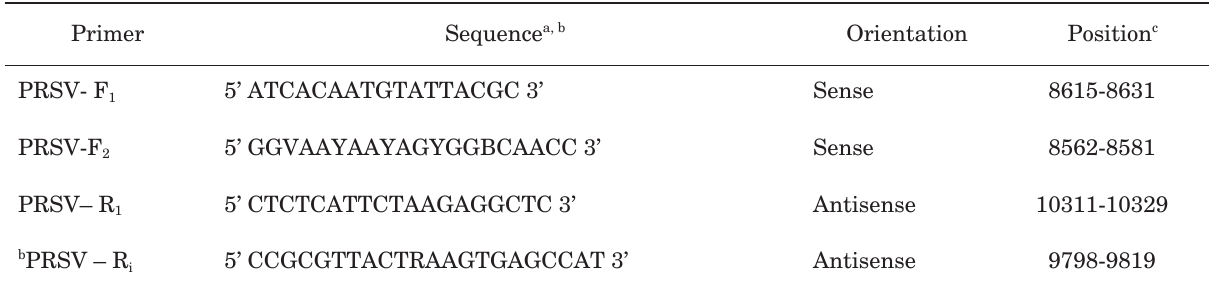
Table 1. Description of the oligonucleotide primers used in this study.